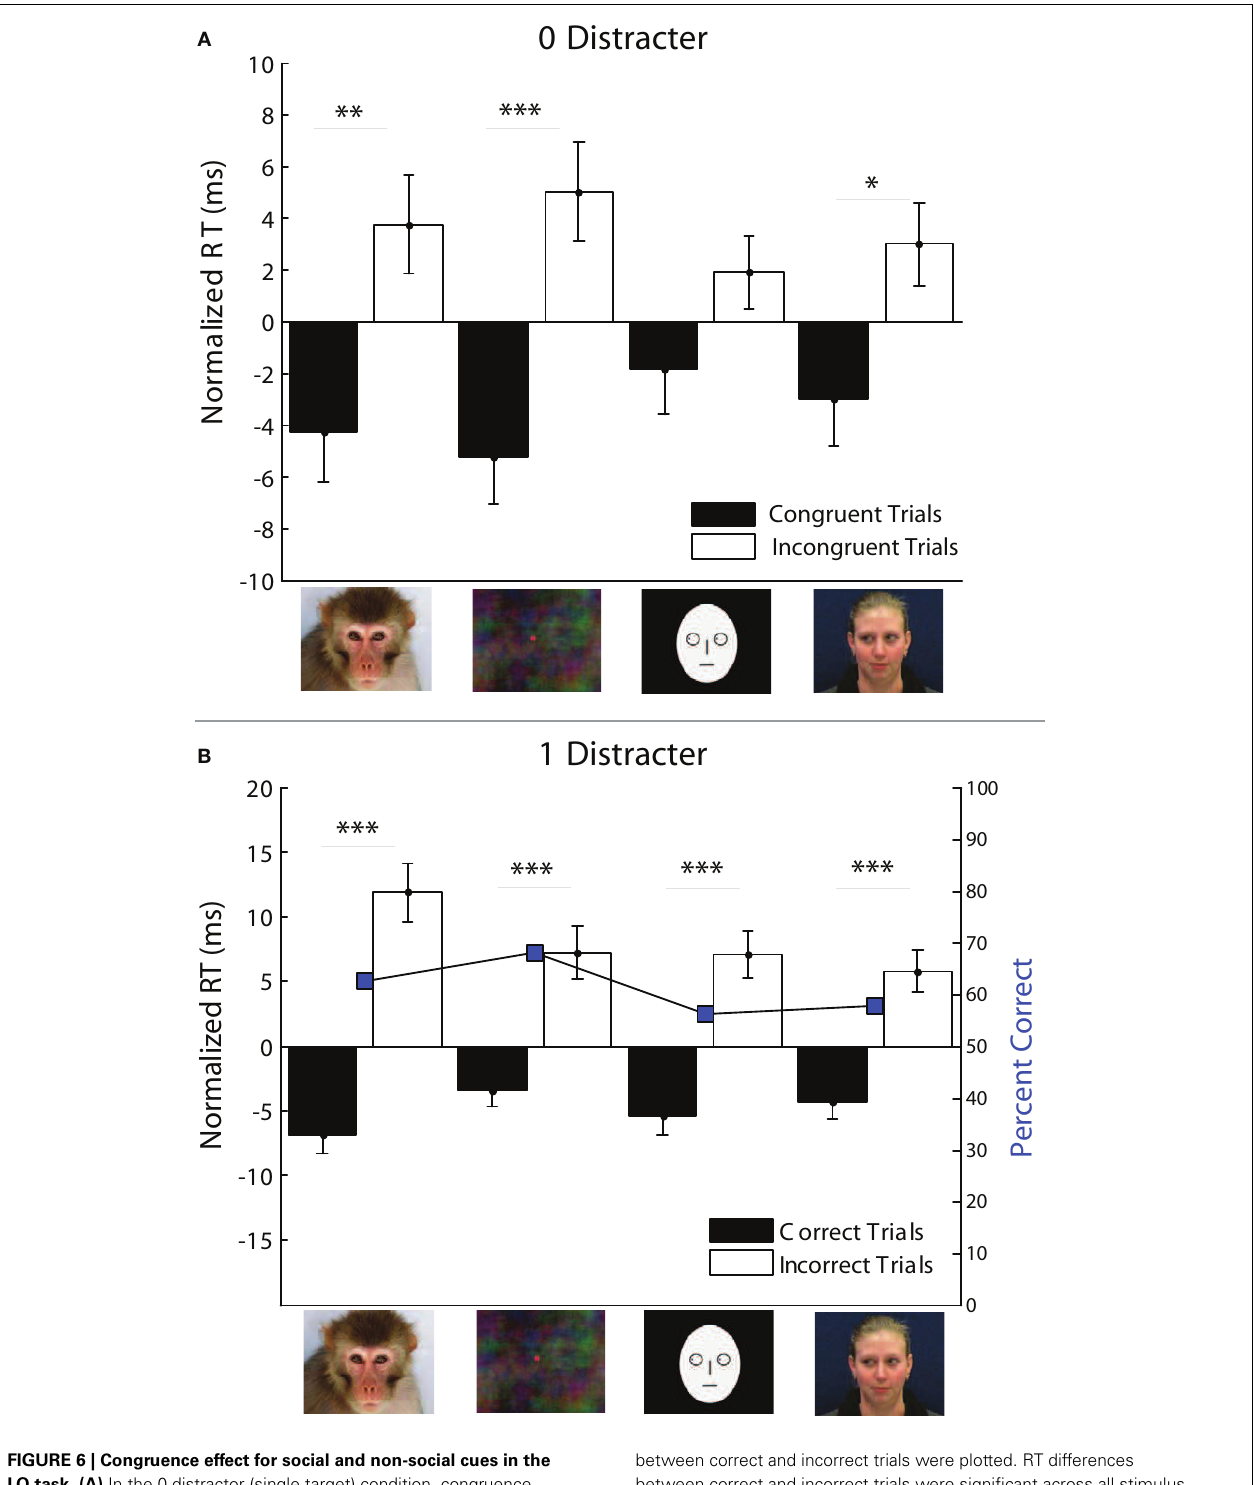
FIGURE 6 | Congruence effect for social and non-social cues in the LO task. (A) In the 0 distractor (single target) condition, congruence effects were observed for monkey-face, spatial dot, and human-face cues (* p < 0.05, ** p < 0.01, *** p < 0.001). (B) In the 1 distractor condition, mean percent correct and weighted mean RT differences